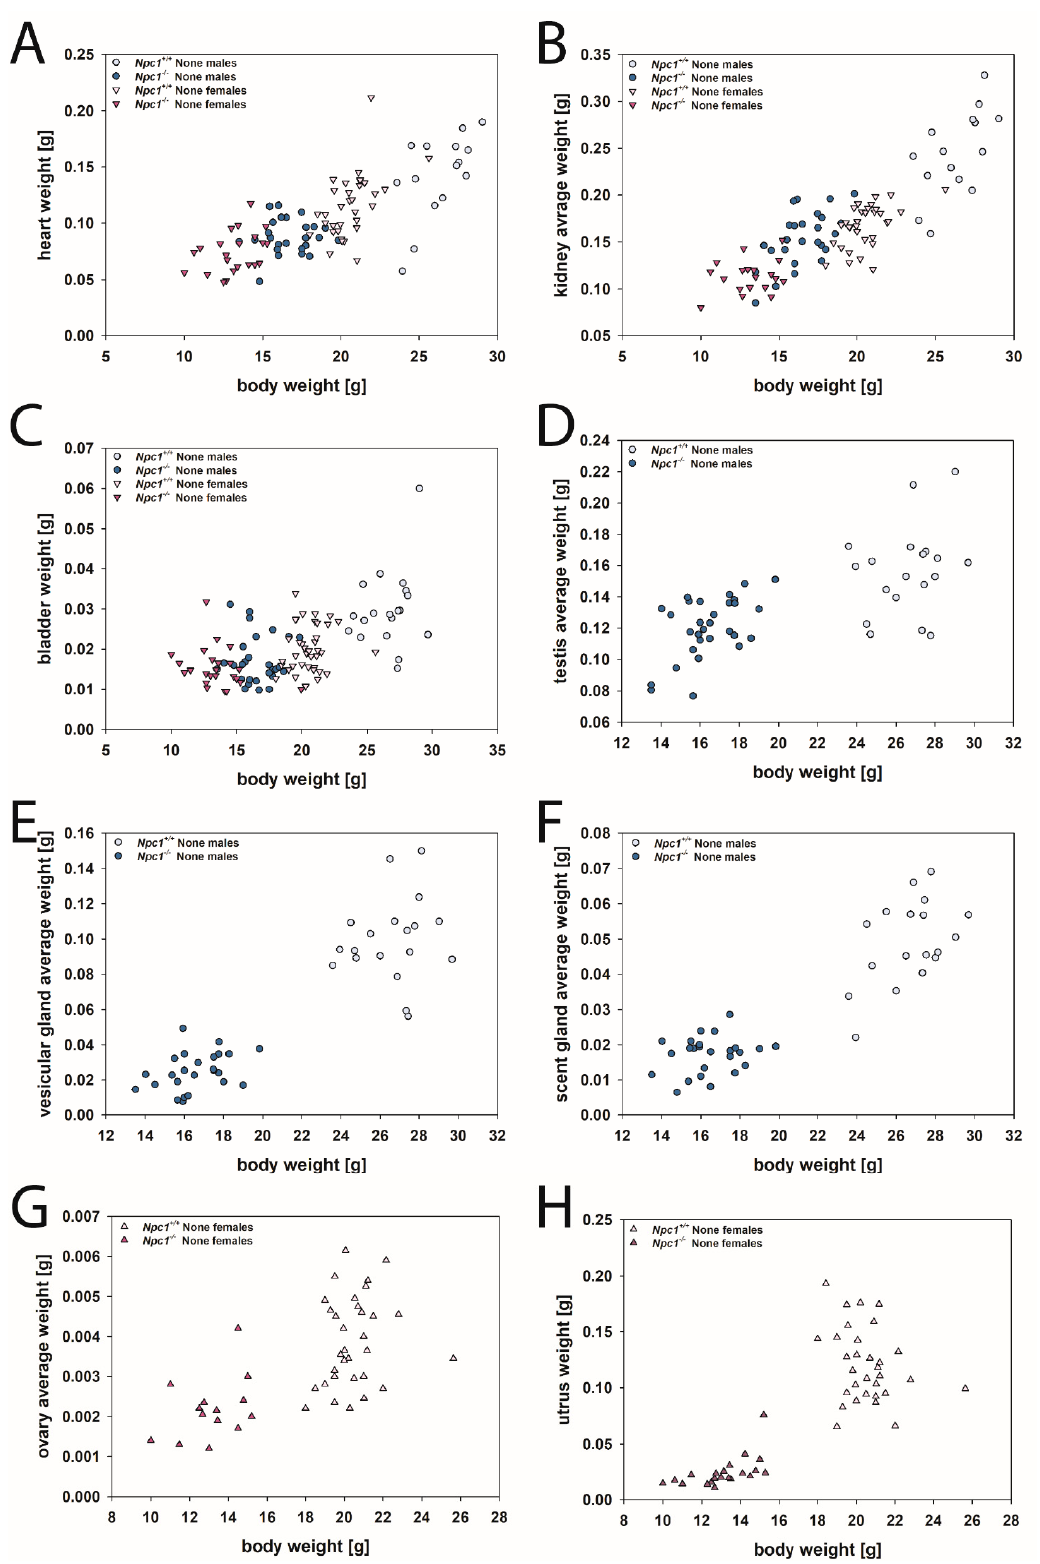
Figure 15. Organ weight in relation to body weight of individual Npc1 − / − and Npc1 +/+ mice of the None groups: ( A ) heart, ( B ) kidney, ( C ) bladder, ( D ) testis, ( E ) vesicular gland, ( F ) scent gland, ( G ) ovary, ( H )